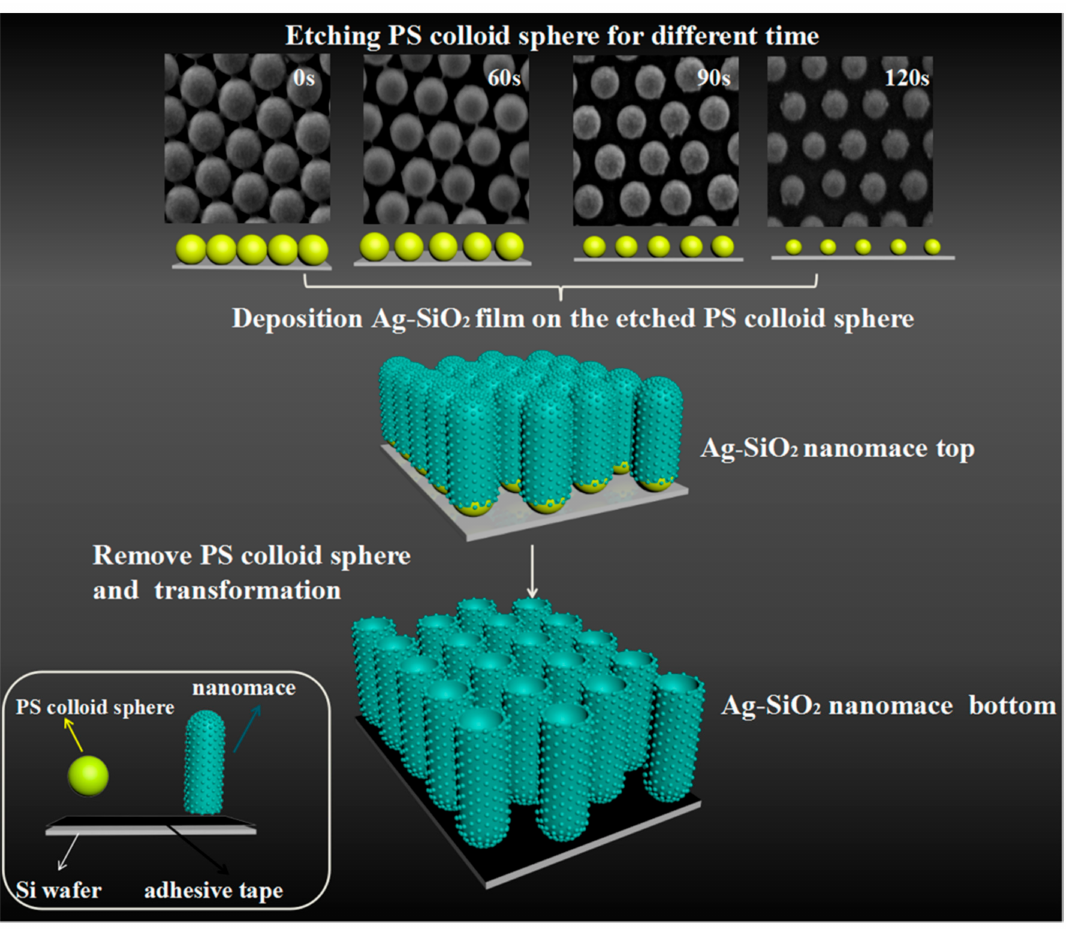
Figure 1. Schematic diagram of the fabrication procedure for Ag–SiO 2 nanomace